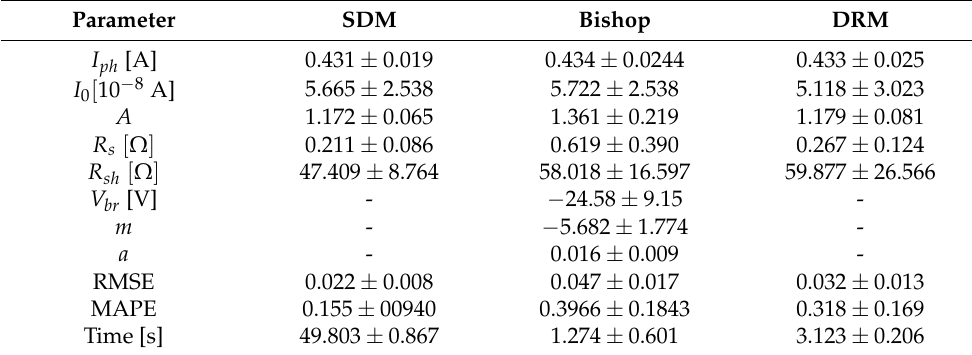
Figure 5. Selection of the estimation parameters for the SDM. ( a ) Mesh of fitness function in relation with the number of iterations and population size. ( b ) Contour of fitness function in relation with the number of iterations and population size. Table 5. Parameters estimated for each model (mean ± standard